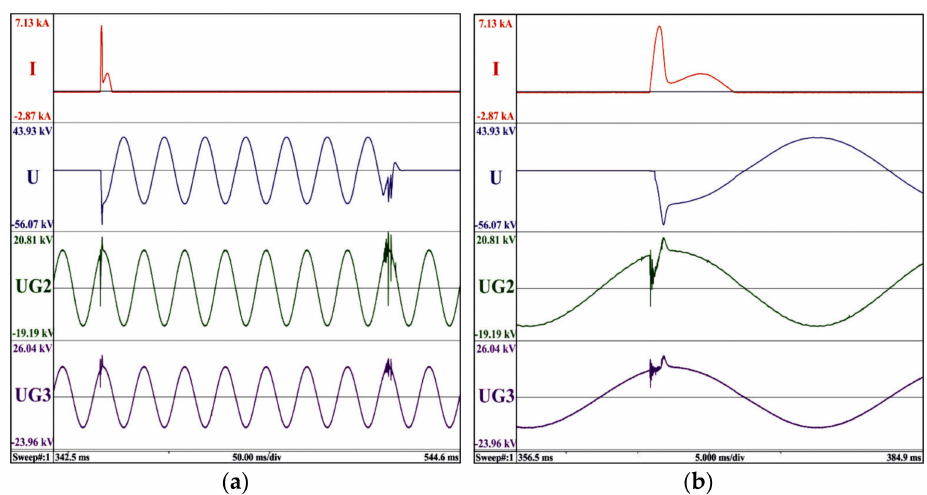
Figure 9. ( a ) Oscillogram obtained for the making angle of short-circuit current of 70 electrical degrees; ( b ) connection detail in the oscillogram.